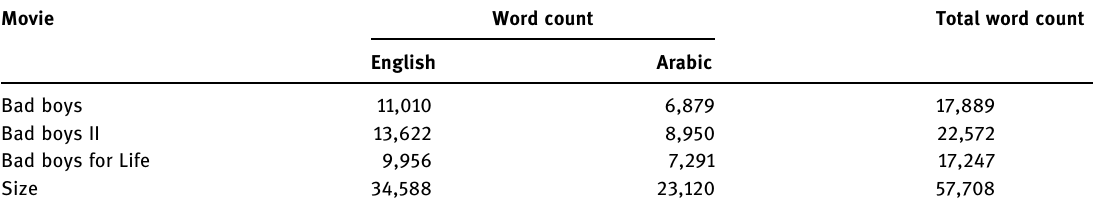
Table 4: Tokens in the movie series Movie Word count Total word count